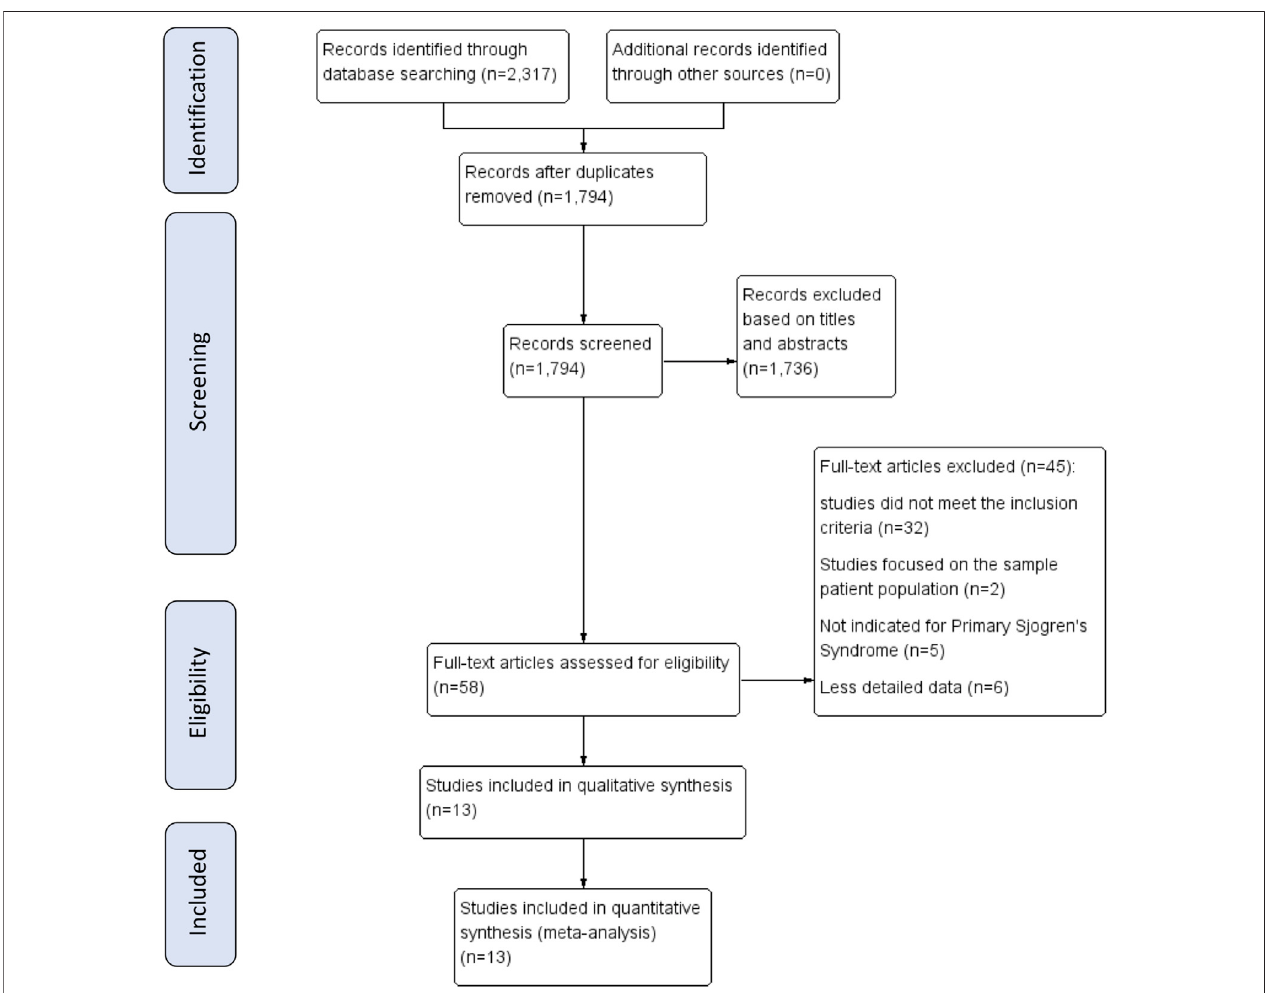
FIGURE 1 | Flow chart of inclusion and exclusion criteria and study